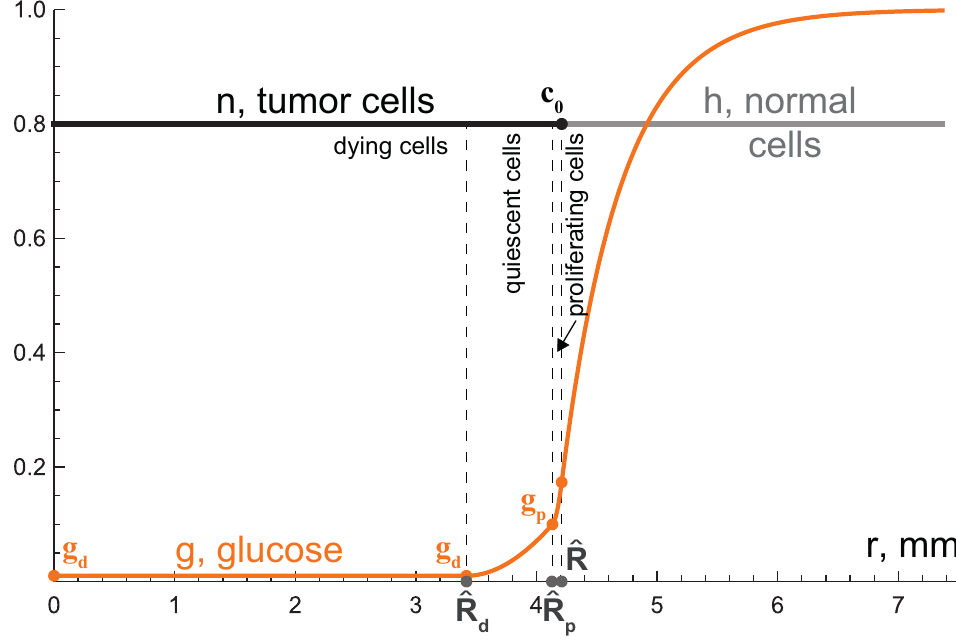
Figure 4. The limit stable distributions of the variables of the tumor growth model, governed by the system of Equation